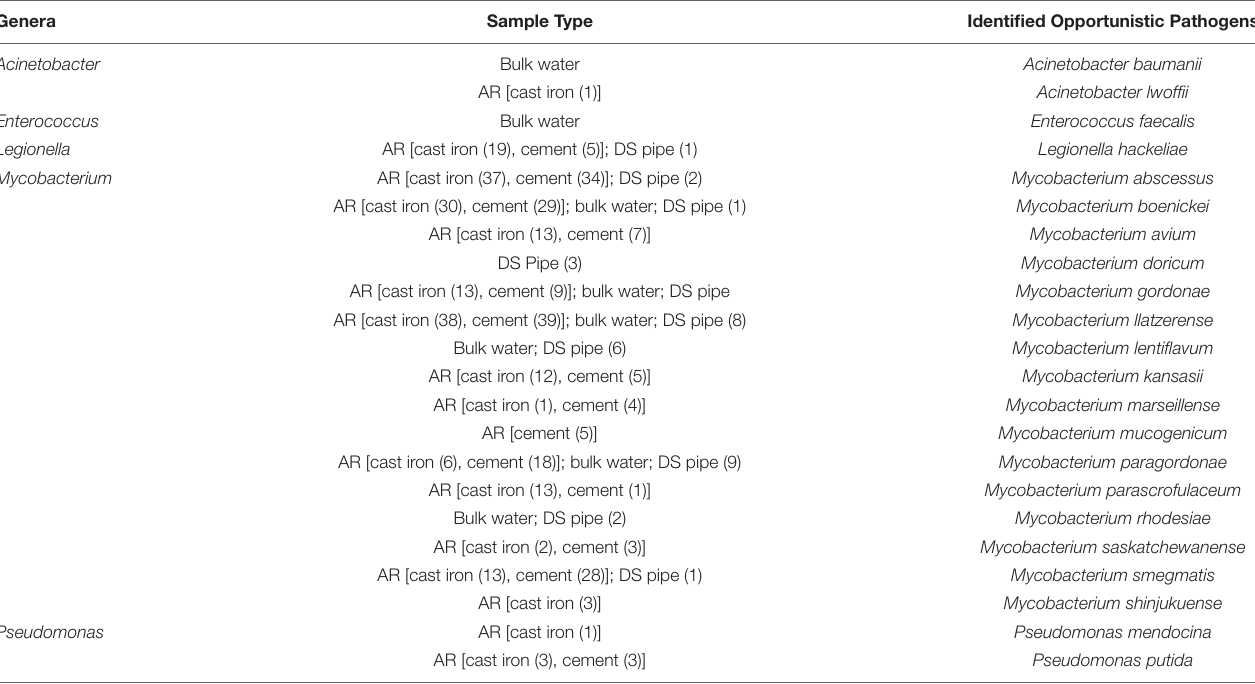
TABLE 2 | Identified opportunistic pathogens in annular reactor (AR; cast iron or cement substrata) biofilm, distribution system (DS) pipe biofilm, and bulk water (distribution system)